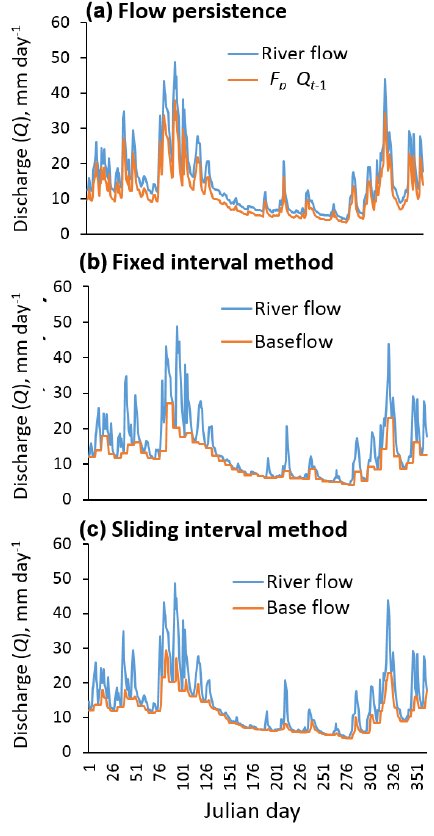
Figure 7. Comparison of base-flow separation of a hydrograph ac- cording to the flow persistence method (a) and two common flow separation methods, respectively, with fixed (b) and sliding inter- vals (c)